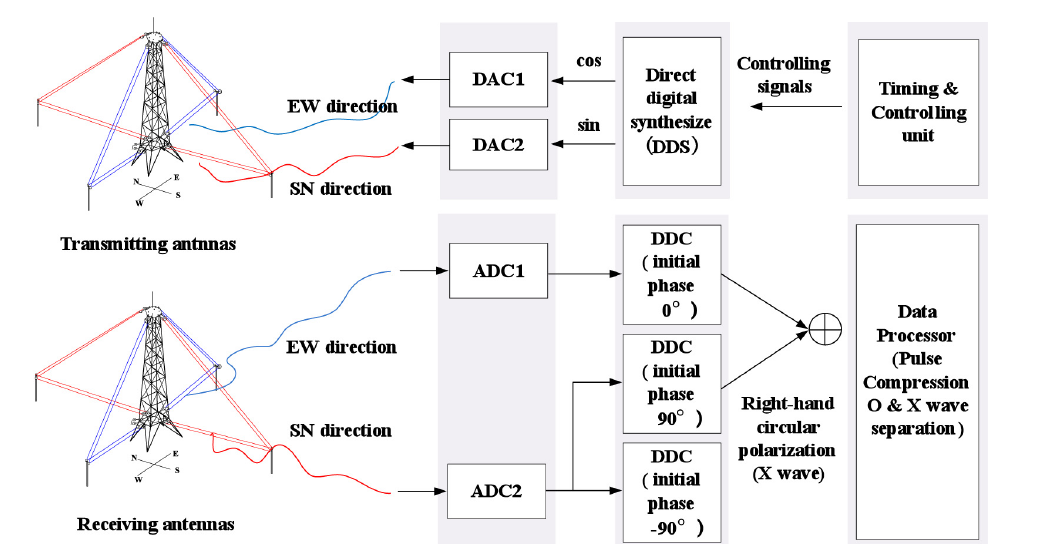
Figure 5. Block diagram for separating X wave in